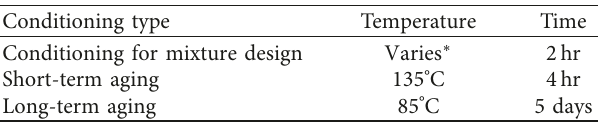
Table 3: Temperature and time duration for different conditioning